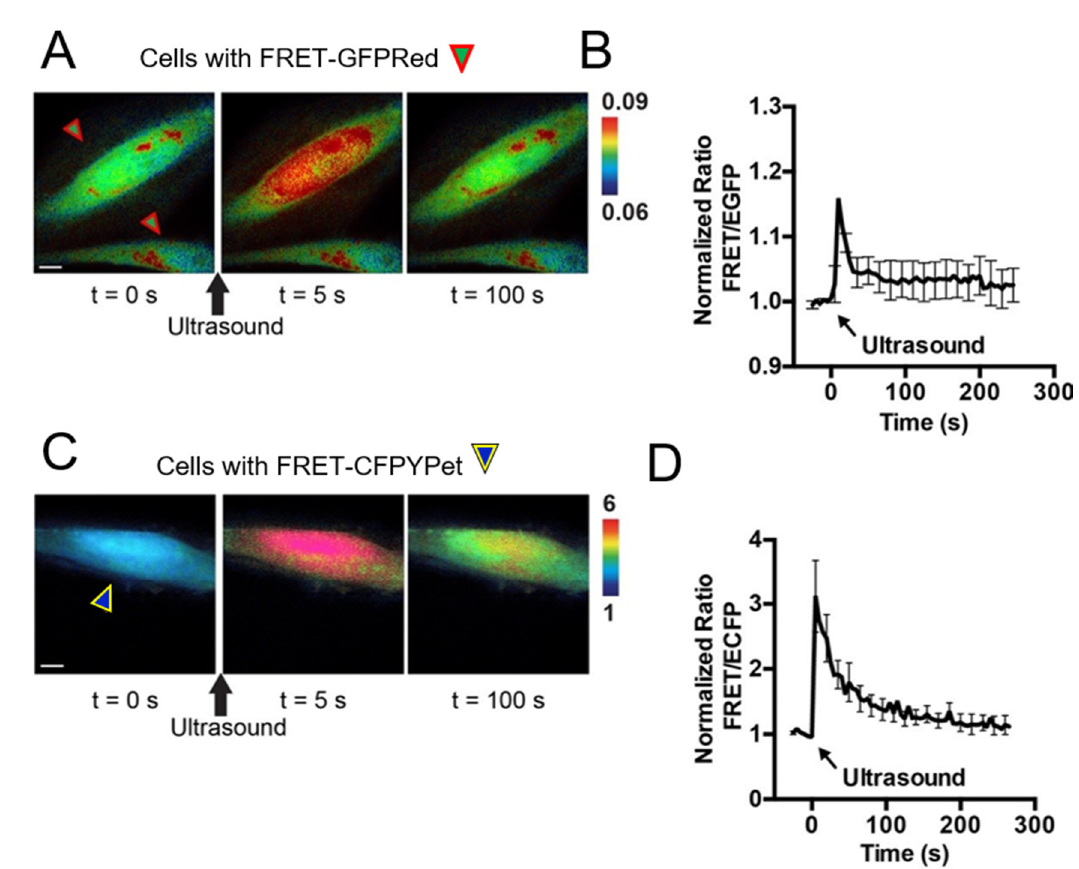
Figure 4. A new FRET-based Ca 2+ biosensor with EGFP and FusionRed fluorophores (FRET-GFPRed) stimulated with high frequency ultrasound. A FRET-based Ca 2+ biosensor with ECFP and YPet (FRET-CFPYPet) was used for comparison. FRET-GFPRed and FRET-CFPYPet were transfected by Llipofectamine 3000. ( A ) Representative FRET/EGFP ratio images of FRET-GFPRed expressed HeLa cells before (t = 0 s), 5 s, and 100 s after ultrasound stimulation. FRET images were taken using the filter setting GR as shown in Figure 3A. A high frequency ultrasound was used to target only the upper cell for ultrasound stimulation. The lower cell was not stimulated. ( B ) Time course of the FRET/EGFP signal ratio of FRET-GFPRed after ultrasound stimulation is presented. ( C ) Representative FRET/ECFP signal ratio images of FRET-CFPYPet before (t = 0 s), 5 s, and 100 s after ultrasound stimulation of HeLa cells are presented. FRET images were taken using the filter setting CY as shown in Figure 3B. ( D ) Time course of the FRET/ECFP signal ratio of FRET-CFPYPet after ultrasound stimulation is presented. Green arrowheads surrounded by red lines indicate HeLa cells transfected with FRET-GFPRed. Blue arrowheads surrounded by yellow lines indicate cells transfected with FRET-CFPYPet. Black arrows indicate ultrasound stimulation. The duration of the ultrasound stimulation was from 5 to 10 µs. Scale bars represent 10 µm. Error bars represent +/- one SEM.